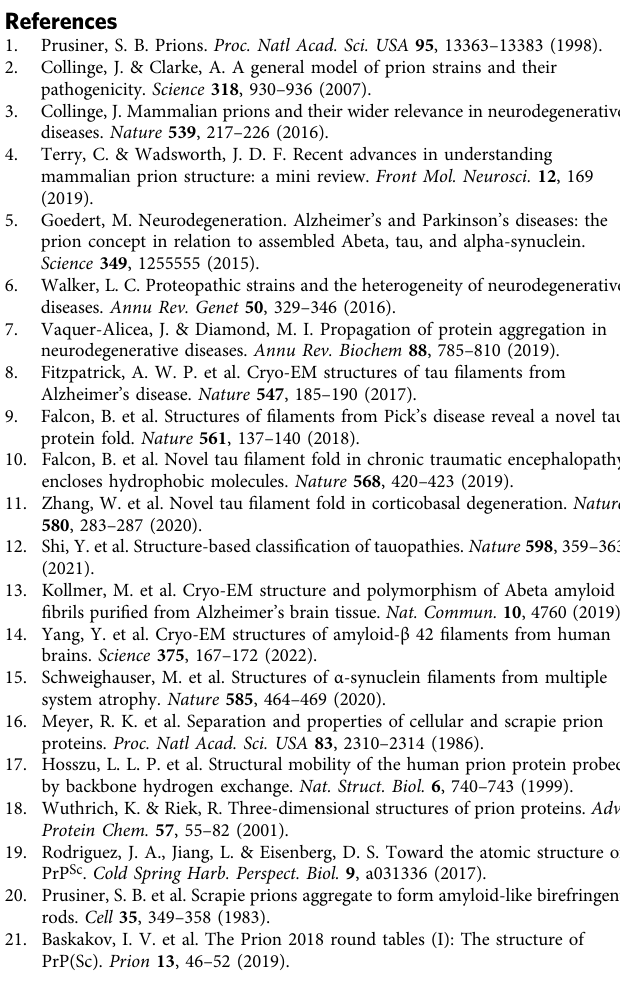
Fig. 4 Comparison of PrP conformation in the RML and the 263K prion fi brils. a Polypeptide backbone superposition on the fi rst two β -strands (N-term alignment; secondary structure not shown) of single PrP monomers from the two different strains, coloured by their deviation in distance. b Surface models showing internal gaps and the divergent angles between the N- and C-terminal lobes. c Top, multiple PrP sequence alignment coloured by conservation and annotated by mouse RML PrP sequence numbering and secondary structure. Mouse vs hamster amino acid substitutions (AAS) that underpin distinct conformations of RML and 263K fi brils are highlighted in red. Bottom, mapping of the selected AAS onto cartoon structures of RML (this study) and 263K (PDB code: 7LNA) fi brils (sticks coloured white and by heteroatom: O, red; S, yellow). Selected conserved residues, including those involved in distinct interactions due to divergent PrP folds are shown with sticks coloured as main chain and by heteroatom (N, blue; O, red; S, yellow). Red arrows indicate different folds of the C-termini, which result in divergent tips of the